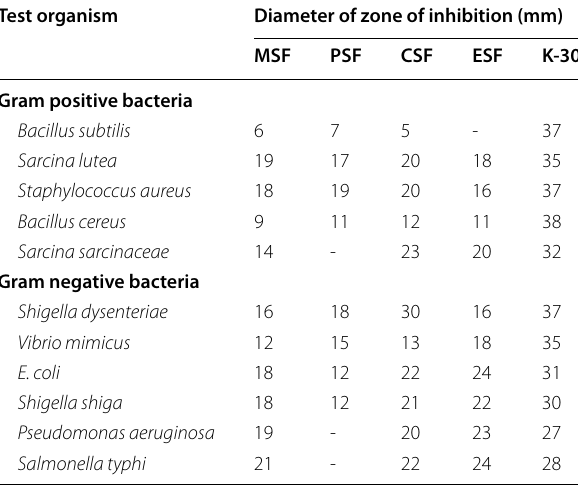
Table 4 Antibacterial activity of the different fractions of C. asiatica